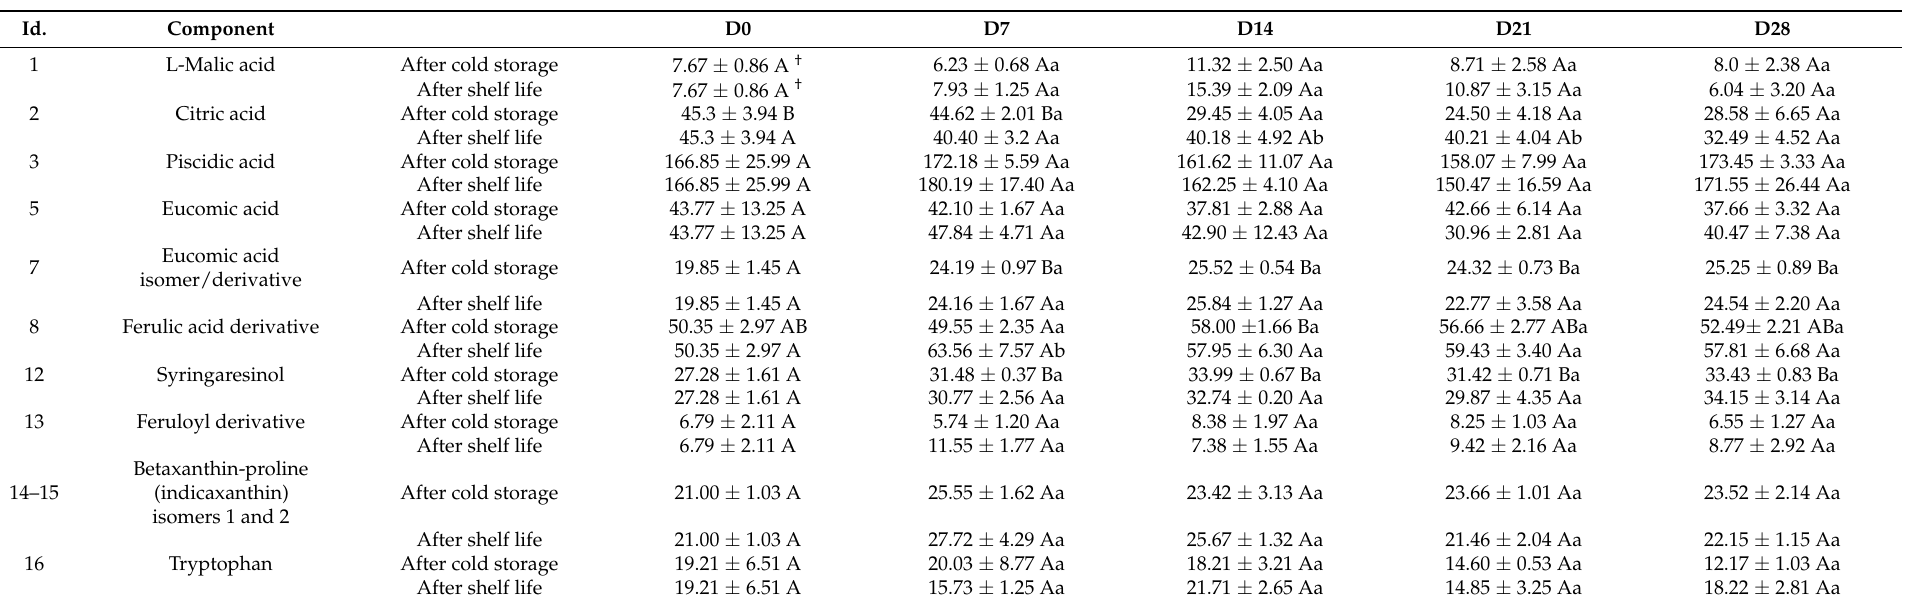
Table 3. Average of area (mAU*min) for each component detected in O. ficus-indica (L.) Mill. samples at 280 nm, except components 14–15 (474 nm), during cold and shelf life storage.